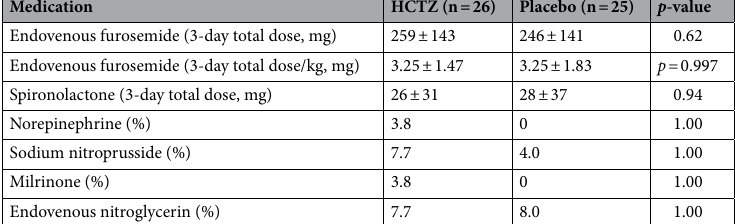
Table 2. Therapies during the study. Plus–minus values are means ± standard